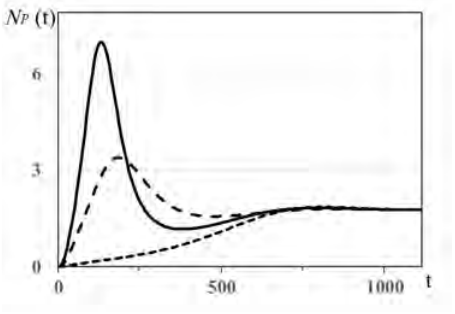
Fig. 13. of N S ( t ) for oscillating dynamics for 2 different initial values ϕ ( a )